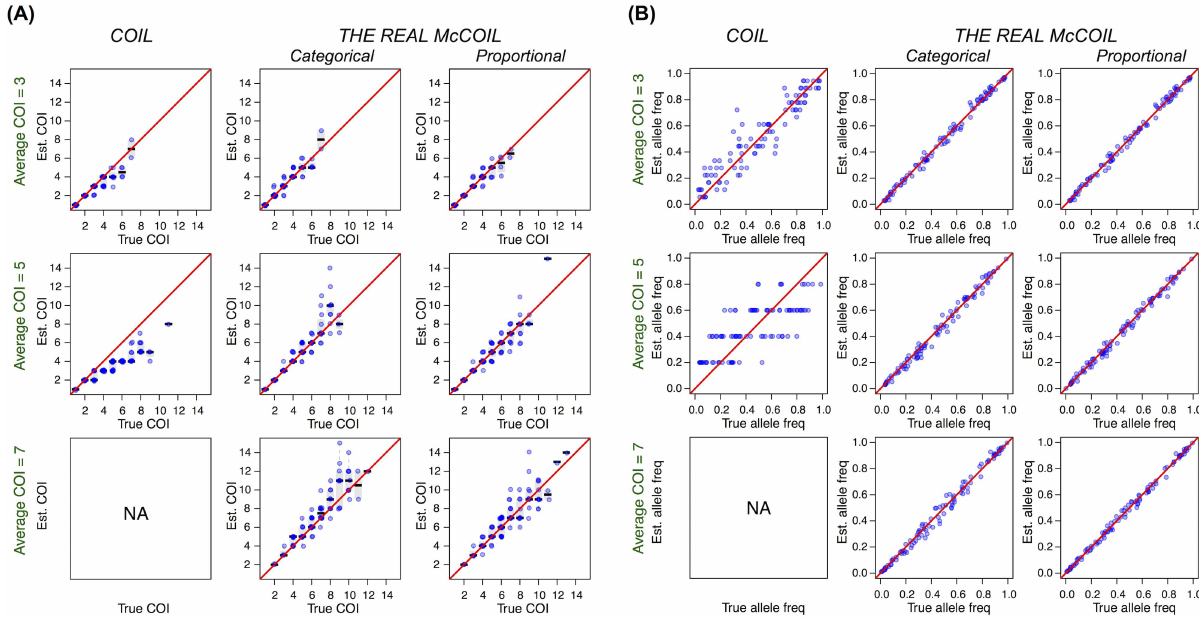
Fig 1. True vs. estimated values of COI (A) and allele frequencies (B) using COIL and THE REAL McCOIL . Each blue dot represents a sample. The black bar and the grey box show the median and 25% to 75% quantile. THE REAL McCOIL estimated allelefrequencies and COI better than COIL , especiallywhen the averageCOI was high and the majority of infectionswere polygenomic.